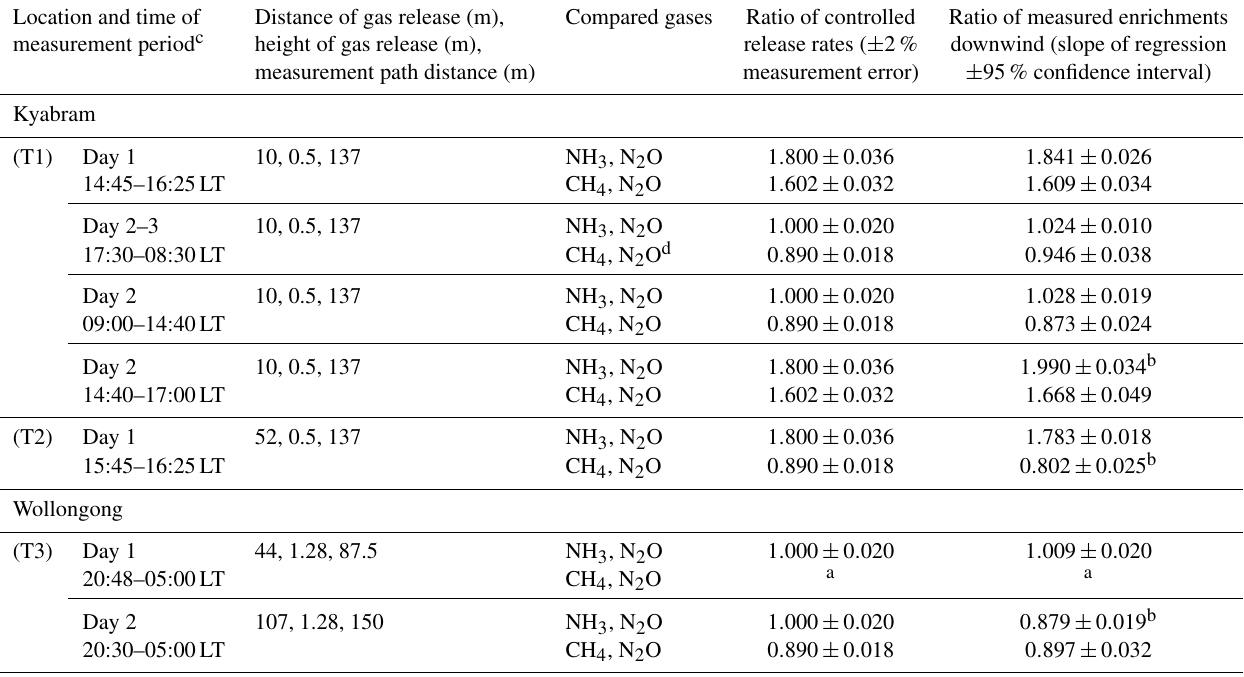
Table 4. Comparison of the release rate ratios and OP-FTIR-measured enhanced mole fractions for the controlled release gas